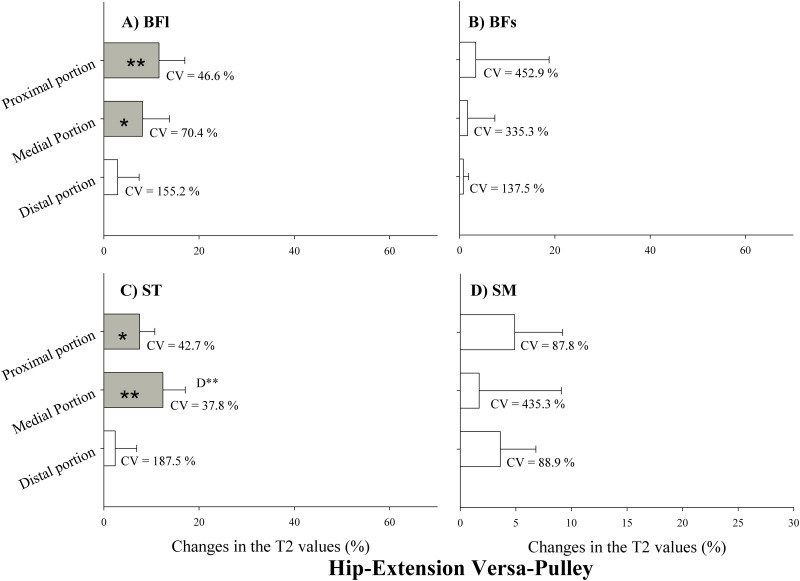
Changes in the transverse relaxation time (T2) values immediately after versa-pulley hip-extension exercise.Values are given as a percentage of the pre-values. BFl: biceps femoris long head; BFs: Biceps femoris short head; ST: semitendinosus; SM: semimembranosus. CV: coefficient of variation. P: proximal portion; M: medial portion; D: distal portion. ** Significant difference between muscle regions (p<0.01). * Significant difference between muscle regions (p<0.05). Open bars represent no statistical changes.